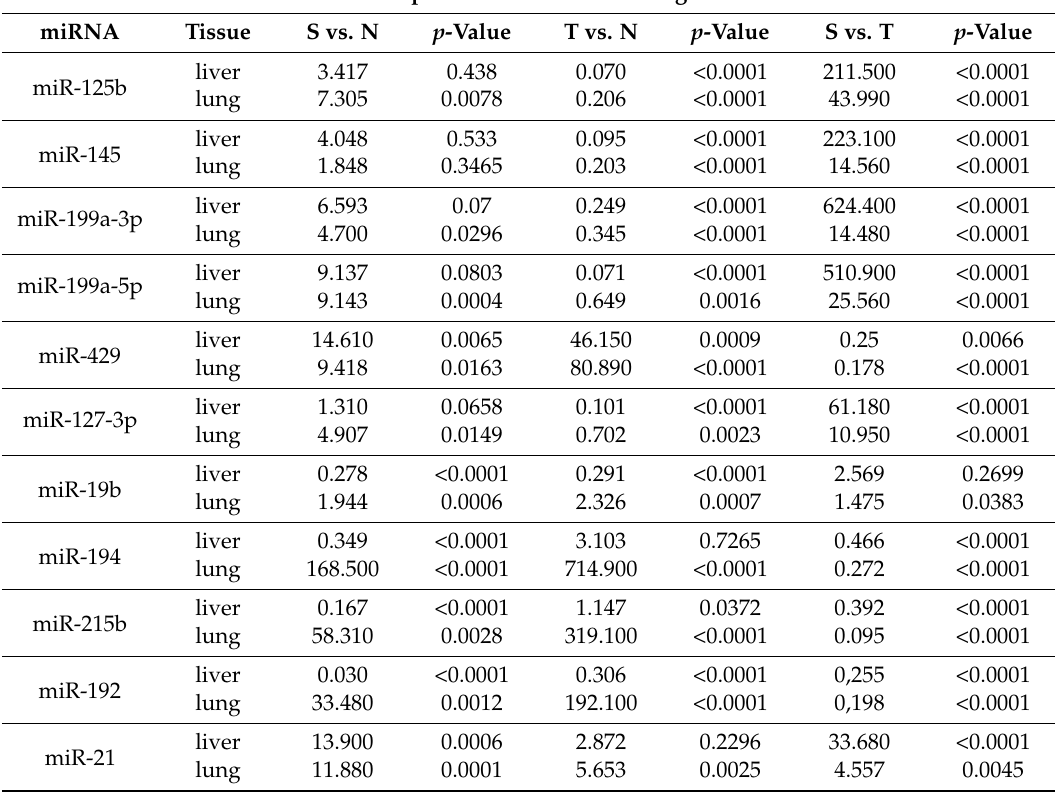
Table 2. Differential expression between the tumor (T), the stroma (S), and the normal tissue (N) compartment (fold change, p -values were calculated using a Wilcoxon signed-rank test). Differential Expression in Liver and Lung Metastases